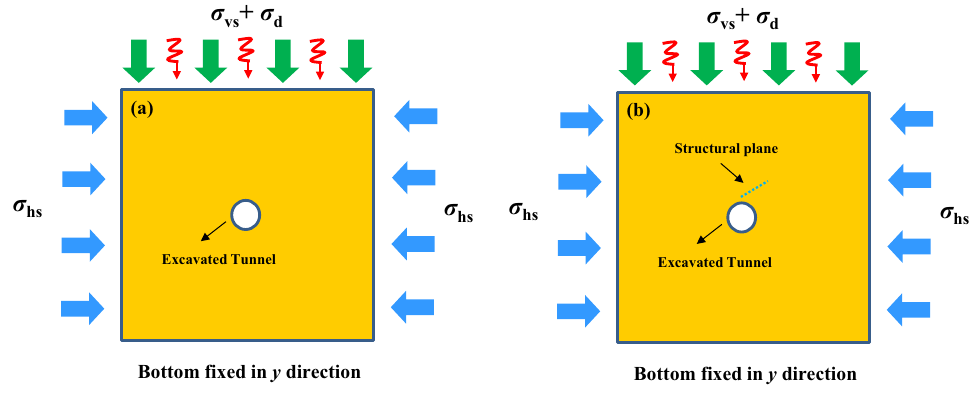
Fig. 4 Combined static and dynamic loads in the model. a Model without structural plane; b Model with structural plane. Note: σ vertical static stress, and σ hs indicates the horizontal static